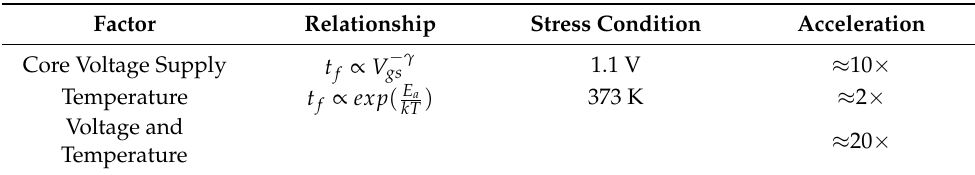
Table 1. Conditions of accelerated